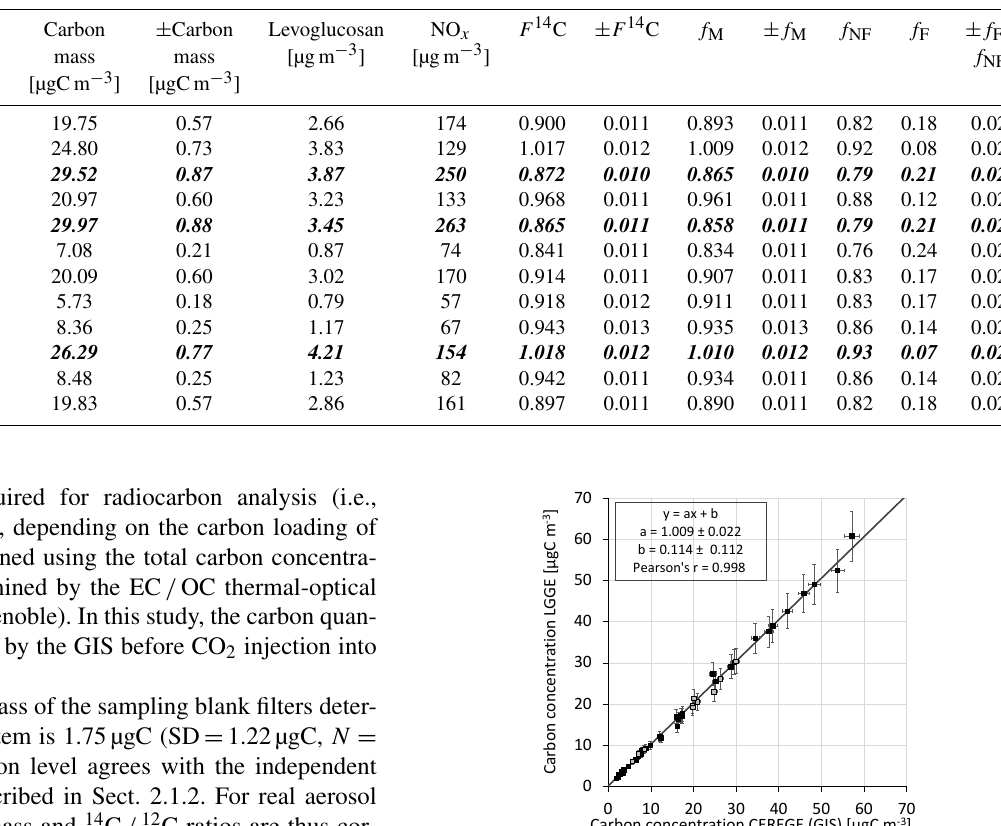
Table 4. Results of analysis of Chamonix samples. PM 10 is determined by TEOM-FDMS; days with a PM 10 concentration higher than 50µgm − 3 (winter smog) are reported in bold italic. Levoglucosan and NO x concentrations: see text. Carbon concentration is determined using the GIS quantification and is expressed with its confidence interval. Each radiocarbon value (expressed in F 14 C and f M ) is based on duplicate measurements: here the weighted mean and its weighted error (2 σ i.e., 95% confidence interval) are presented. Fossil and non-fossil fractions ( f F and f NF ) are determined by the radiocarbon measurements (see Eq. 6).